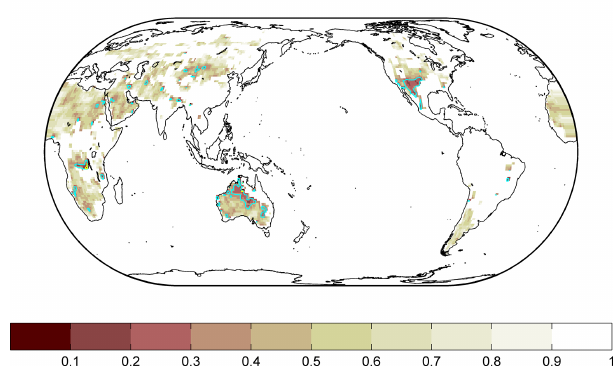
Figure 3. As in Fig. 1, except for the probability of the absence of Granger causality from ENSO and annual mean dust emission over the period 1850–2014 for the historical experiment. ENSO: El Niño–Southern